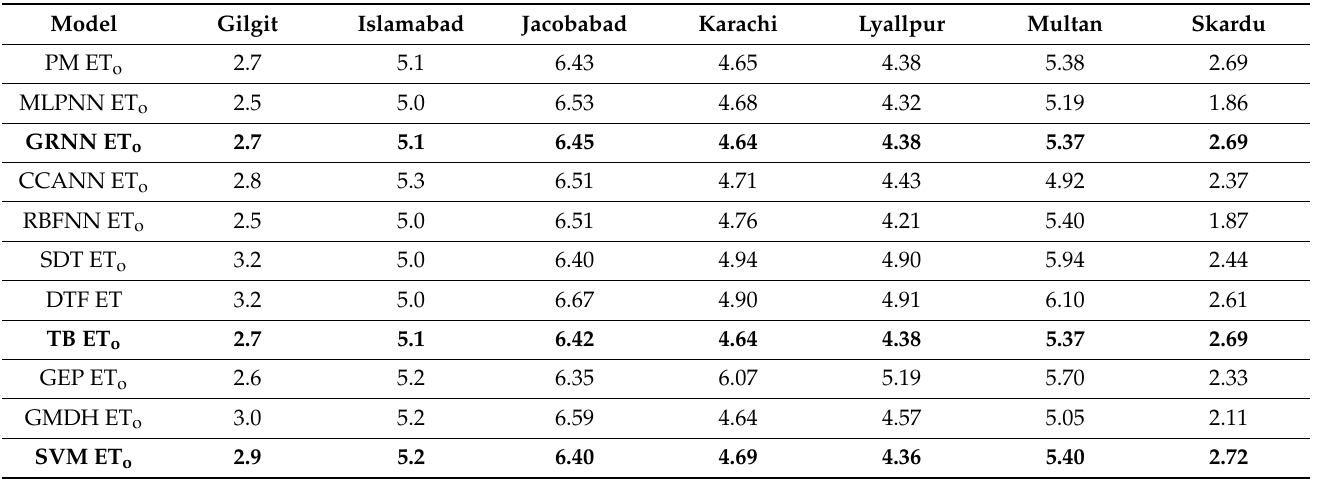
Table 8. Comparison of PM ET o with ML ET o .